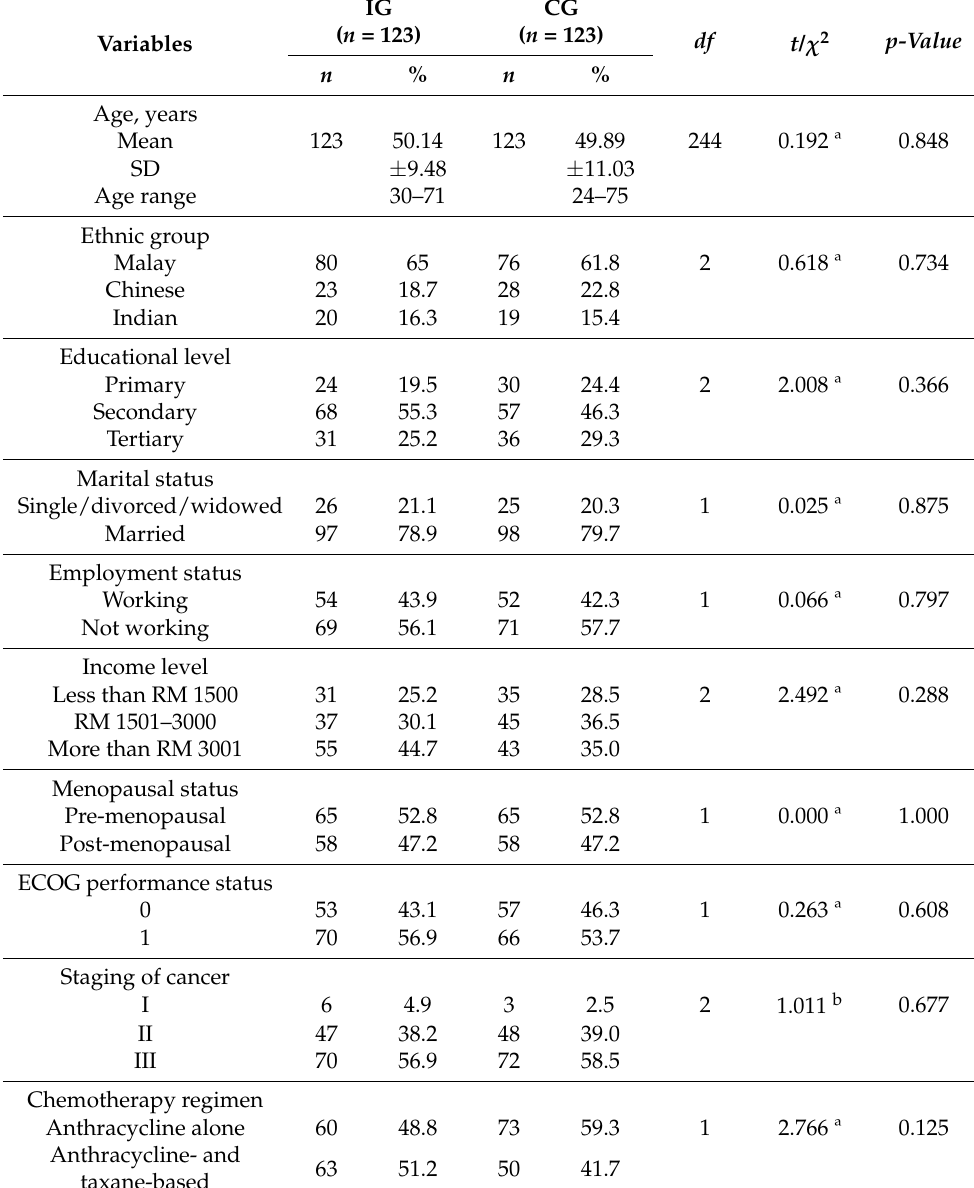
Table 1. Demographic and medical variables between intervention (IG) and control group